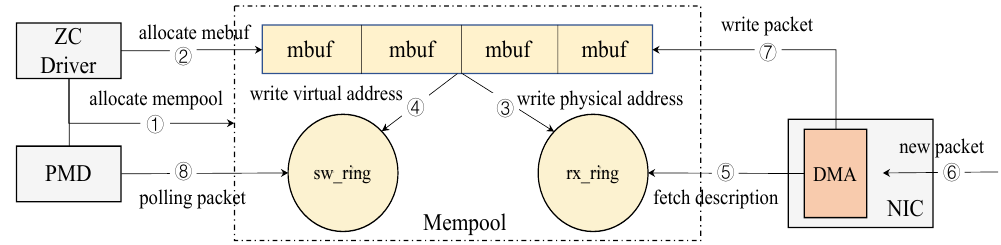
Figure 4. Zero-copy